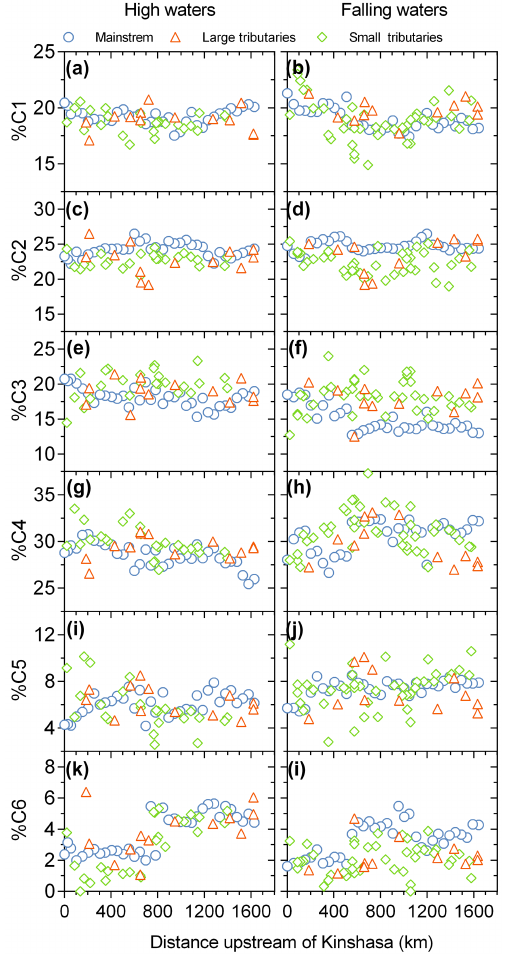
Figure 5. Longitudinal evolution of the relative contribution of PARAFAC component in the mainstem and large and small tribu- taries along the Kisangani–Kinshasa transect during HW (left pan- els) and FW (right